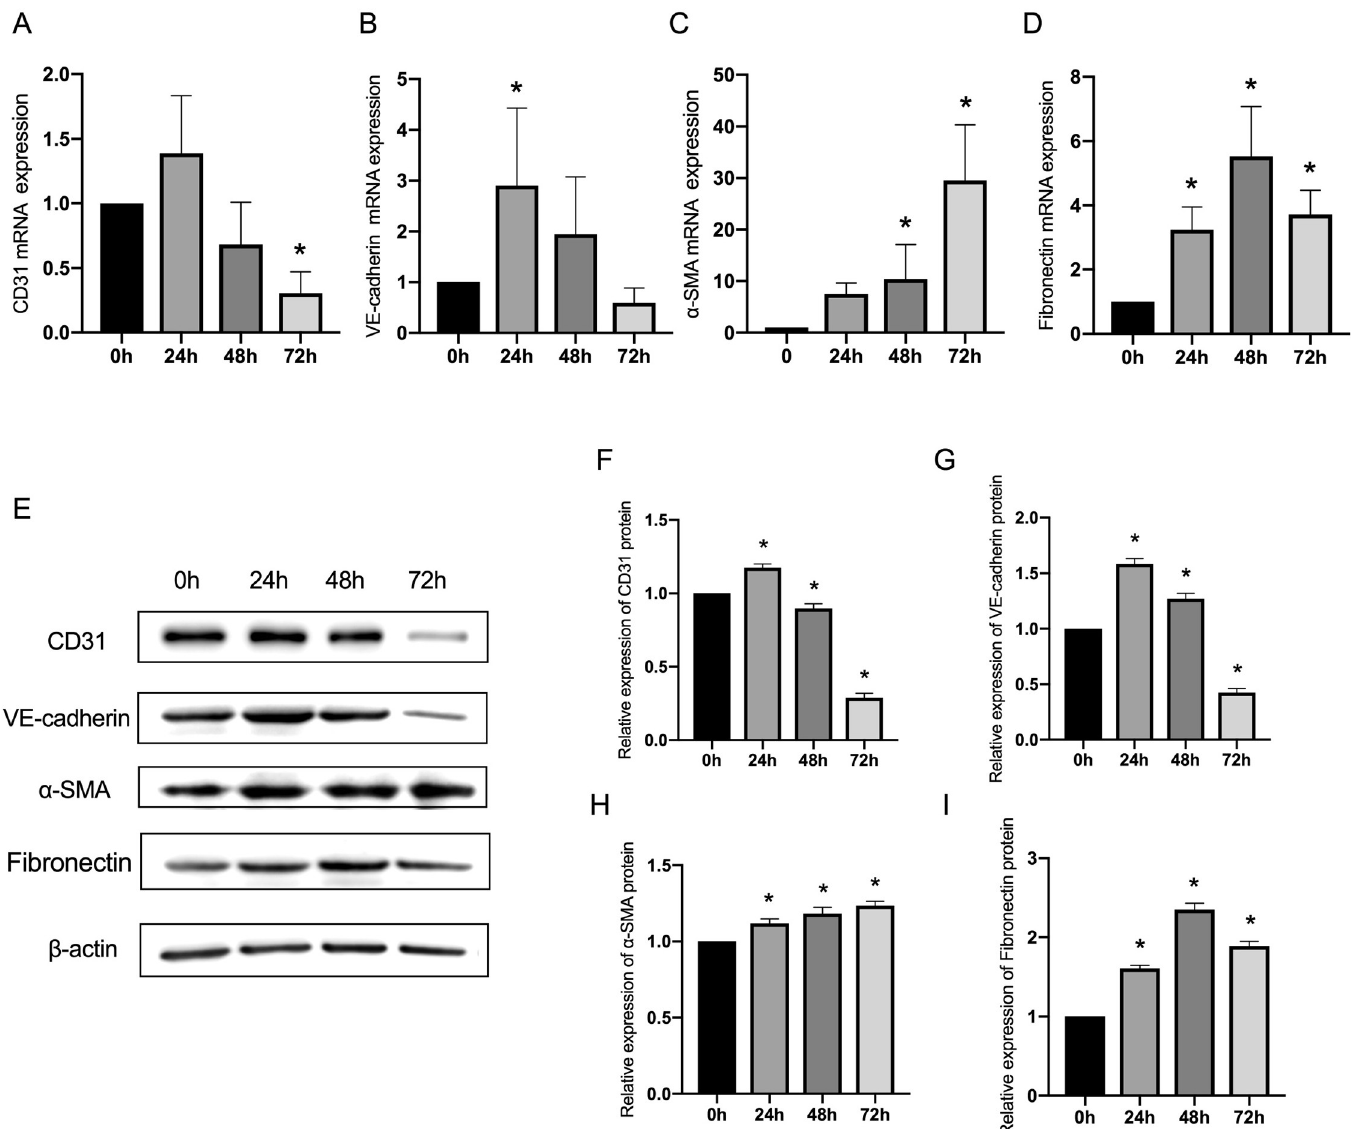
Fig 2. The hypoxia-induced changes of endothelial and fibrotic markers. (A, B, C and D) ECs were exposed to hypoxia for 72 hours, and the mRNA expression was analyzed. (E) The endothelial marker CD31, VE-cadherin, and fibrotic marker α -SMA and fibronectin were detected at protein level by Western blot. (F, G, H and I) Densitometric analyses of the western blot experiments. The above experiments were repeated three times independently. The statistical differences were assessed by one- way analysis of variance (ANOVA) (Kruskal–Wallis), followed by Dunn’s post hoc test. � P < 0.05 against the untreated condition. The graph bars show the mean ± SD.